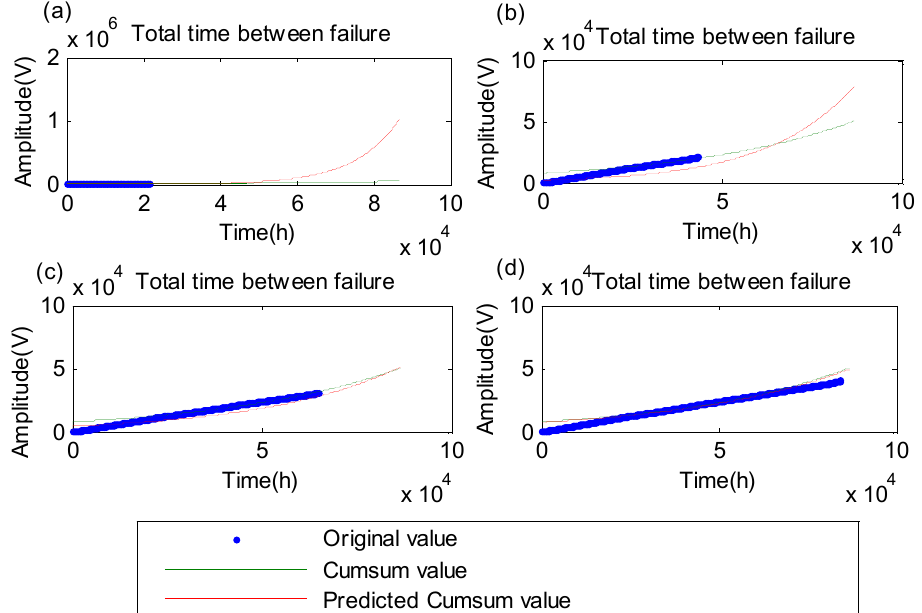
Figure 13. The RUL prognostics results with kurtosis of the accumulative signal utilizing the proposed method: ( a ) prognostics result based on 25% of the accumulative data; ( b ) prognostics result based on 50% of the accumulative data; ( c ) prognostics result based on 75% of the accumulative data; ( d ) prognostics result based on 100% of the accumulative data. Table 1. The accuracy of RUL prognostics with the amplitude feature.